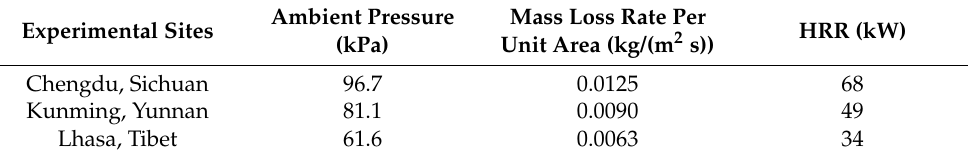
Table 5. Results of mass loss rate per unit area and HRR at stable stage.